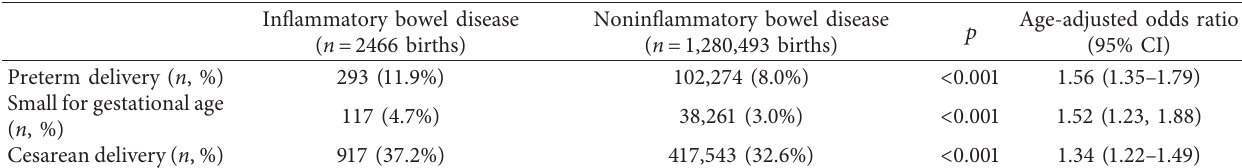
Table 2: Rates of preterm delivery, infants born small for gestational age, and Cesarean delivery for women with and without inflammatory bowel